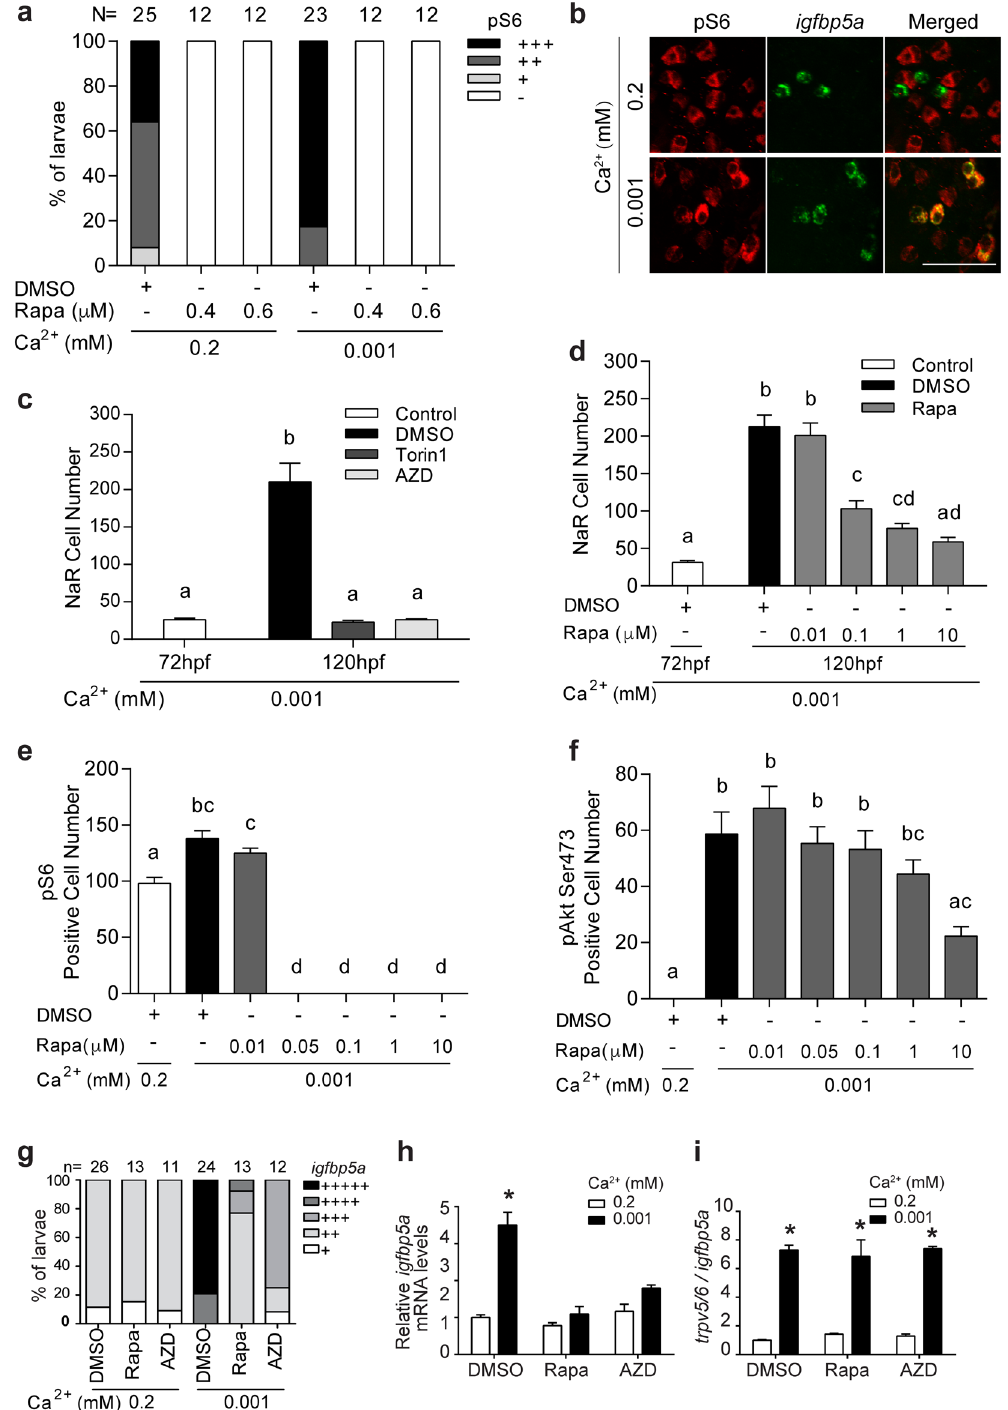
Figure 7. Activation of Tor signaling in NaR cells is required for their proliferation under low [Ca 2 + ] stress. ( a ) Low [Ca 2 + ] stress increases Tor signaling. 72 hpf wild type larvae were transferred to the indicated solutions. After 24 hours, they were stained using a pS6 antibody, and the results were quantified following the score system shown in Supplemental Fig. S7a. The total numbers of larvae are shown on the top of each column. ( b ) Low [Ca 2 + ] activates Tor signaling in NaR cells. Larvae described in ( a ) were analyzed by pS6 immunostaining (red, left panel) and in situ hybridization for igfbp5a mRNA expression (green, middle panel). Merged views are shown in the right panel. ( c ) Tor inhibition abolishes NaR cell proliferation under low [Ca 2 + ] stress. 72 hpf Tg ( igfbp5a : GFP ) larvae were treated and analyzed as described in Fig. 6. Inhibitors used are Torin1 (1 μ M) and AZD8055 (AZD, 1.25 μ M). ( d ) Dose-dependent effects of rapamycin (Rapa). Data shown are mean ± SEM, n = 10–13. Different letters indicate statistically significant differences at p < 0.05. ( e , f ) Different effects of rapamycin on Tor and pAkt signaling. Wild type larvae (72 hpf) were transferred to 0.2 mM or 0.001 mM [Ca 2 +